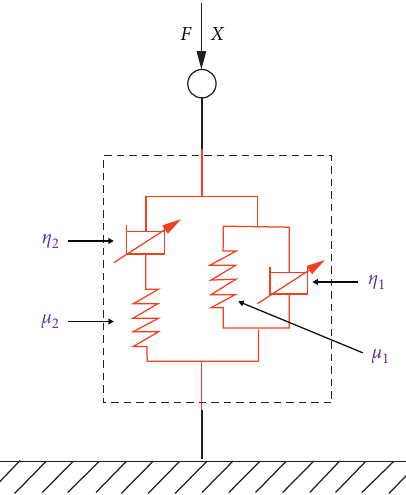
Figure 4: Schematic diagram of the TFDV model of rubber pad under rail.